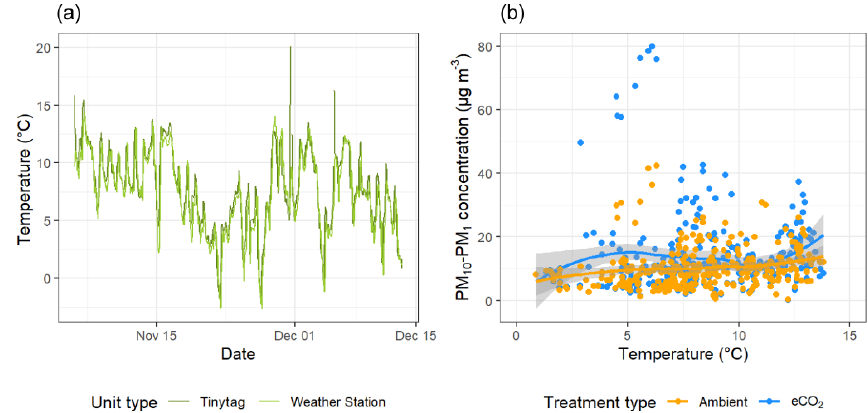
Figure 6. Temperature and bioaerosol (PM 10 –PM 1 ) concentrations across the experimental duration at the BIFoR FACE site. Panel (a) shows temperature data, with mean temperature measured by Tinytag sensors shown in dark green and light green showing data collected by the array 1 weather station. Panel (b) compares temperature data with bioaerosol concentrations with data from ambient arrays (arrays 2, 3, and 5) in blue and data from e CO 2 arrays (arrays 1, 4, and 6) in orange with both treatment types fitted with a loess line (Wickham et al., 2019).